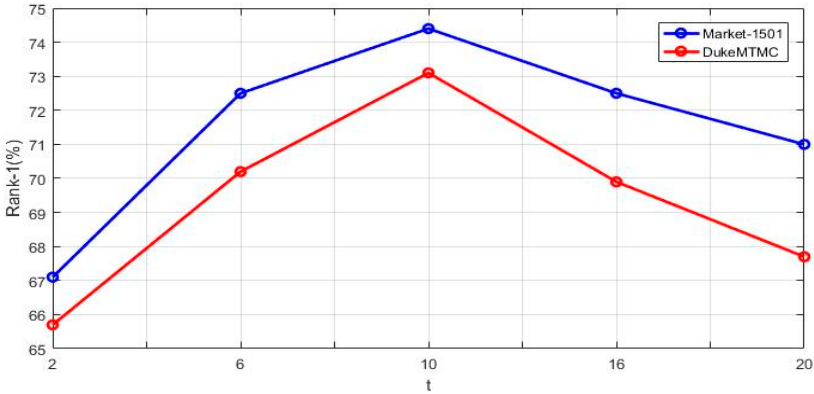
ff ect of the parameters t in loss function L Figure 5. The effect of the parameters t in loss function G L . Figure 5. The e